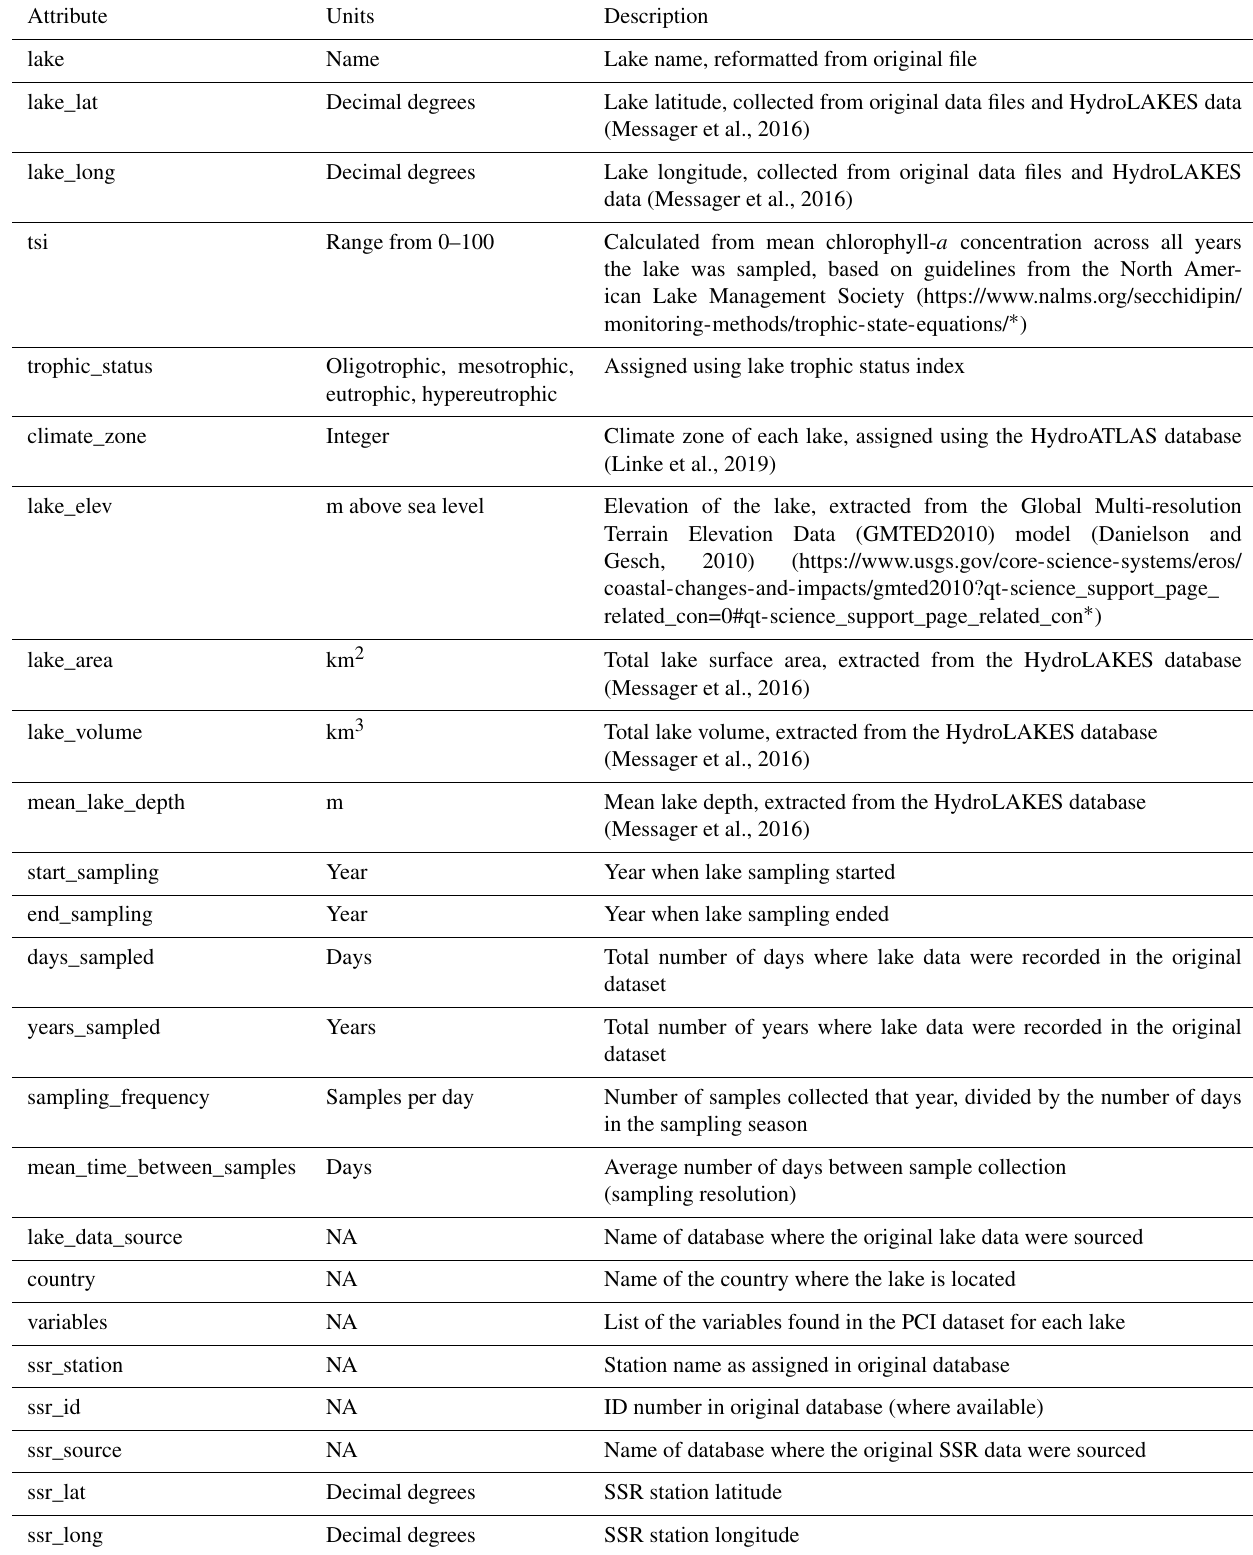
Table A4. Lake attributes published alongside the PCI dataset (https://doi.org/10.20383/102.0488, Adams et al., 2021). ∗ Last access: July